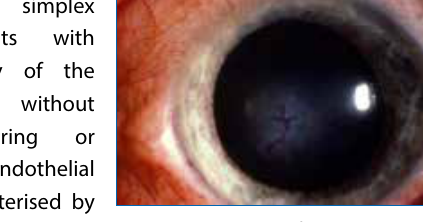
Figure 4: Herpes simplex virus dendritic ulcer